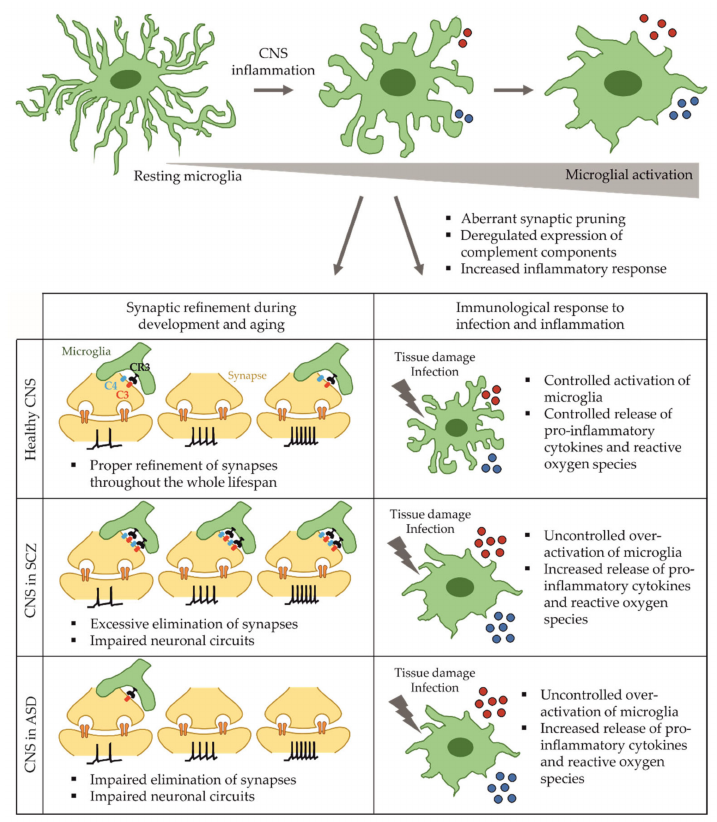
Figure 1. Hypothetical shared and differing pathological phenotypes of microglia in SCZ and ASD. Synaptic pruning of inactive, weak or excessively active synapses is a necessary process during neurodevelopment and aging. For SCZ, it is suggested that overactivated microglia degrade too many active and necessary synapses in a complement-dependent mechanism, thereby impairing neuronal circuits and function. In ASD patients, synapse numbers were found to be increased, indicating reduced synapse elimination by microglia. In both disorders, microglia respond to pro- inflammatory stimulation with an increased immune response accompanied by an enhanced release of pro-inflammatory cytokines and reactive oxygen species, ultimately inducing an impairment of the blood-brain-barrier and the whole